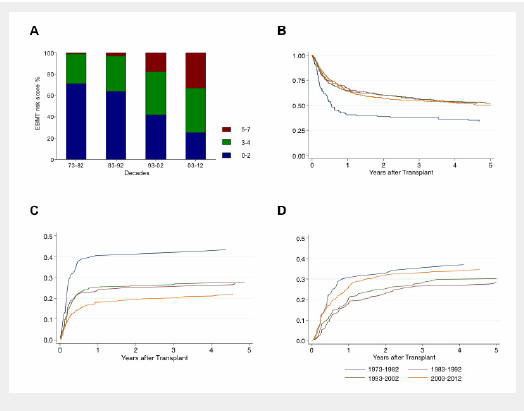
(A) European Group for Blood and Marrow Transplantation (EBMT) risk score distribution in % over the decades for allogeneic haematopoietic stem cell transplantation (HSCT). (B) Overall survival after allogeneic HSCT. (C) treatment-related mortality after allogeneic HSCT. (D) relapse incidence after allogeneic HSCT. EBMT risk score: 0–2 (blue) = low; 3–4 (green) = intermediate, 5–7 (red) = high pretransplant risk constellation